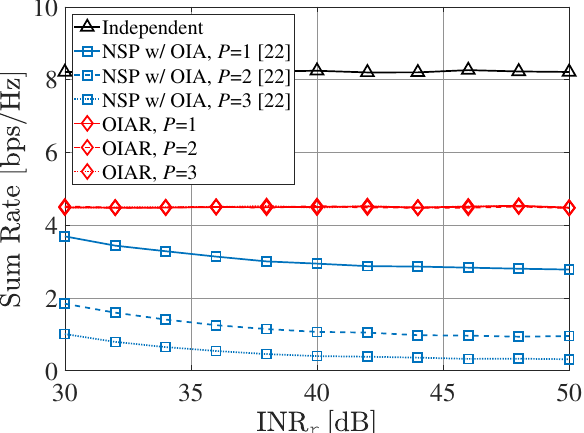
Figure 5. Sum-rate of communication system according to SNR r with different P .